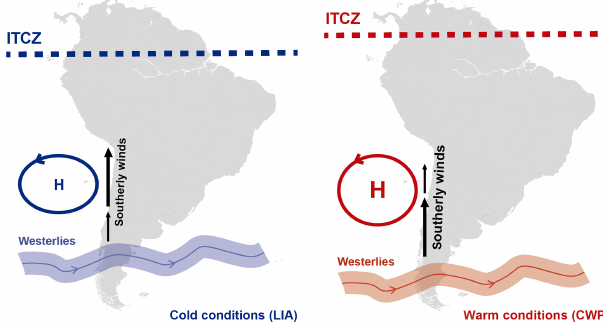
Figure 6. Schematics of the changes proposed in this work. The SPSH has changed from a contracted condition during the LIA pe- riod to an expanded state, with its southern rim reaching higher latitudes during the CWP. Coastal meridional winds appear to be stronger (weaker) south (north) of ∼ 35 ◦ in the prevailing warm conditions. The opposite is observed during the cold period (LIA). The belt of SWWs shows a poleward position in the CWP, while it displays a northward shift during the